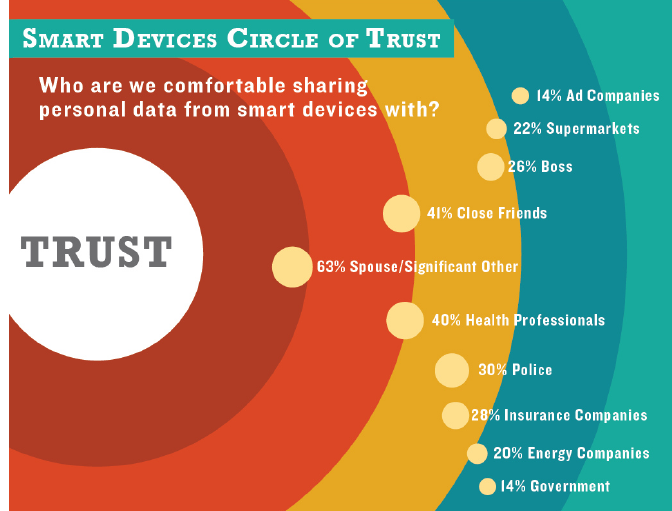
Figure 1. Circle of trust regarding the Internet of Things. Research carried out by TRUSTe. Source: